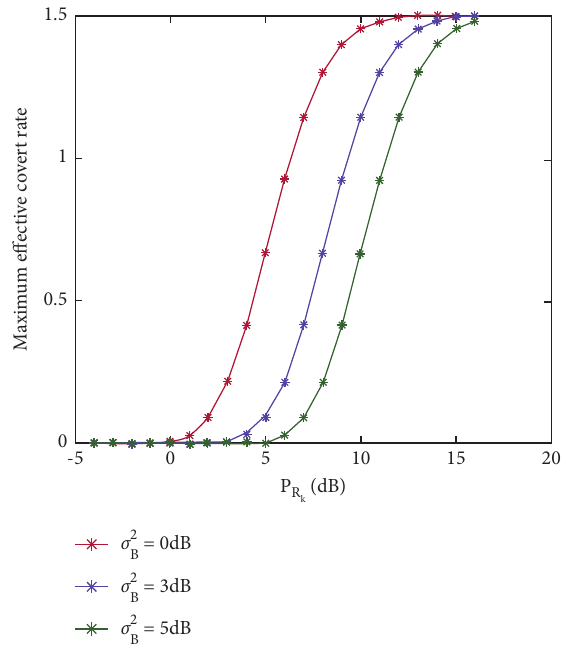
Figure 16: Maximum effective covert rate versus P max | 2 , where R � 1 . 5, N value of | h R j W